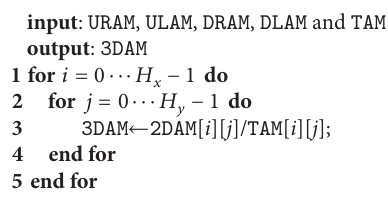
Algorithm 7: EVC heuristic: Compute 3DAM() .